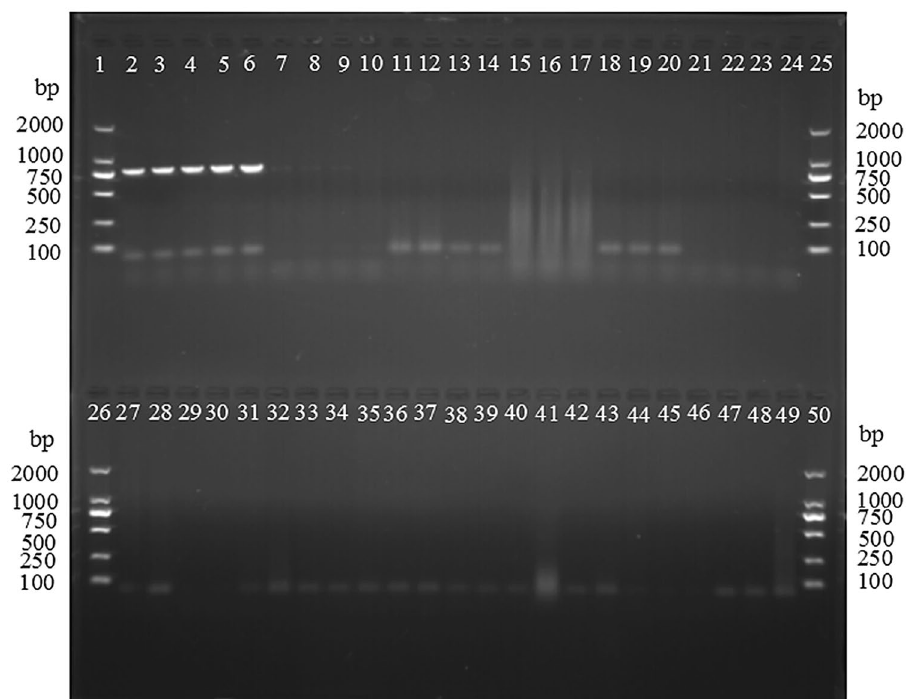
Figure 3. PCR with SCAR primers (L57F/L57R) to amplify genomic DNA from Tilletia laevis and other species. Lanes 2–6: T. laevis, Lanes 7–9: T. controversa, Lanes 10–12: T. caries , Lanes 13–16: Ustilago tritici , Lanes 17–19: Puccinia striiformis. f. sp. tritici , Lanes 20–22 : U. hordei , Lanes 23–24, Lanes 27–28: P. triticina , Lanes 29–33: U. maydis ; Lanes 34–36: Rhizoctonia cerealis , Lanes 37–38 : Fusarium graminearum , Lanes 39–42: Bipolaris sorokiniana, Lanes 43–45: P. graminis f. sp. tritici , Lanes 46–48: Blumeria graminis f. sp. tritici ; Lane 49: ddH 2 O, Lanes 1, 25, 26, 50: marker D2000.